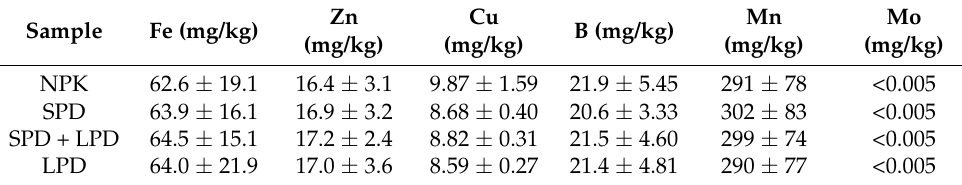
Table 11. Microelements content in soil samples after harvest of plants in dry matter.